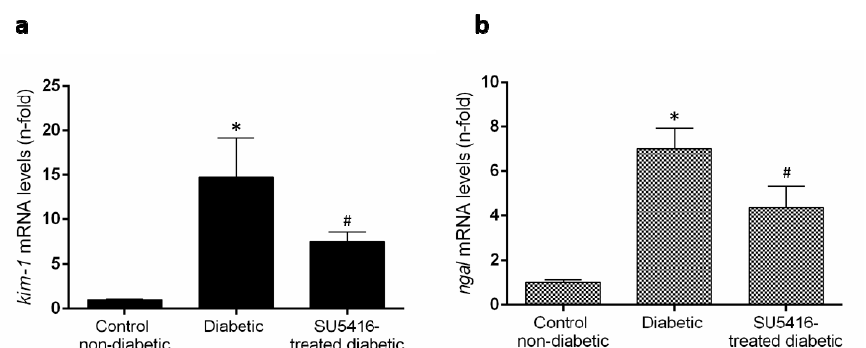
Figure 4. VEGFR2 blockade diminished overexpression of damage markers in murine diabetic kidneys. Gene expression levels of the biomarkers of renal damage, ( a ) kidney injury molecule-1 ( kim-1 ) and ( b ) neutrophil gelatinase-associated lipocalin ( ngal ) were assessed at the end of the study at 20 weeks. Data as mean ± SEM of 6–8 mice per group. * p < 0.05 versus control non-diabetic, # p < 0.05 versus diabetic.